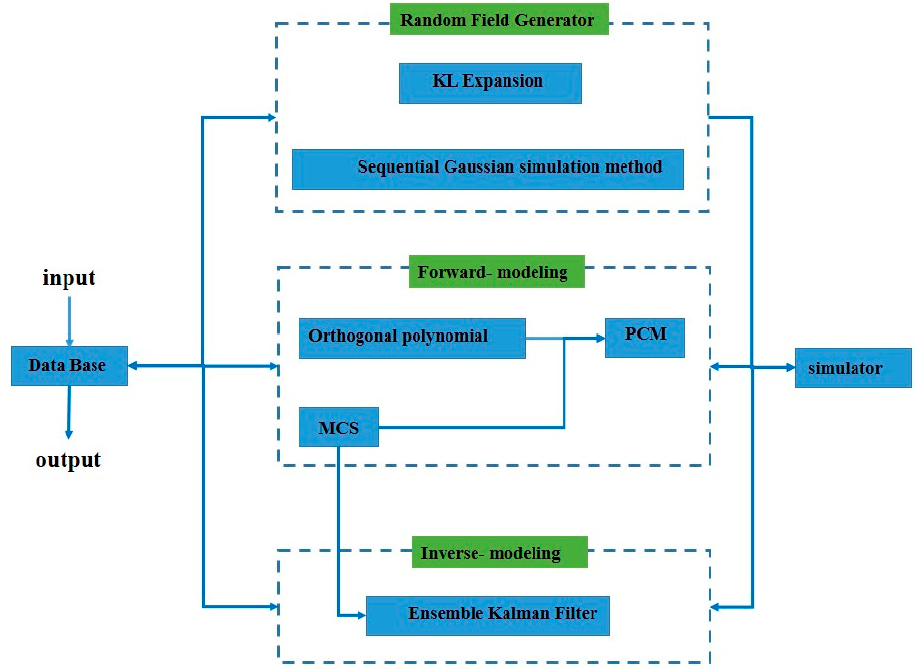
Figure 1. The structure of Genpack. KL: Karhunen–Loeve; MCS: Monte Carlo simulation; PCM: Probabilistic collocation method.